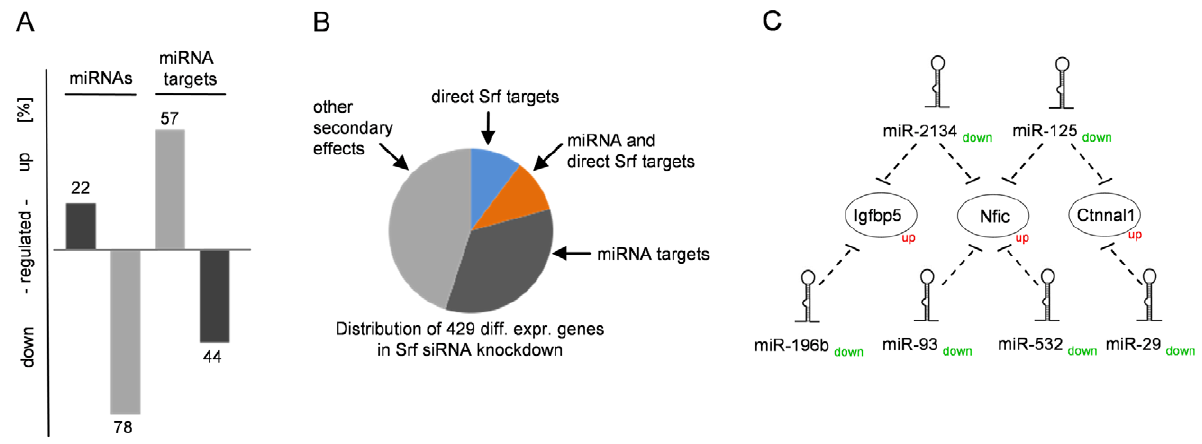
Figure 5. miRNAs and their impact on the Srf-driven transcription network. (A) RNAi knockdown of Srf in HL-1 cardiomyocytes results in 42 differentially expressed miRNAs (49 loci) (Table S10). Target prediction of these mostly downregulated miRNAs revealed 192 differentially expressed genes, with a higher fraction of upregulated genes (57% of all upregulated genes) compared to downregulated genes (44% of all downregulated genes). (B) Direct Srf targets represent only a small fraction of all differentially expressed genes in Srf knockdown (orange and blue). Targets of differentially expressed miRNAs impact 45% (dark grey) with a partial overlap of direct Srf targets (orange). Approximately 50% of differential expression is driven by other secondary effects (light grey). (C) Exemplary network of indirect gene regulation by miRNAs. The genes Igfbp5, Nfic and Ctnnal1, which are not directly bound by Srf, are predicted targets for a set of downregulated miRNAs and are found to be upregulated in the Srf